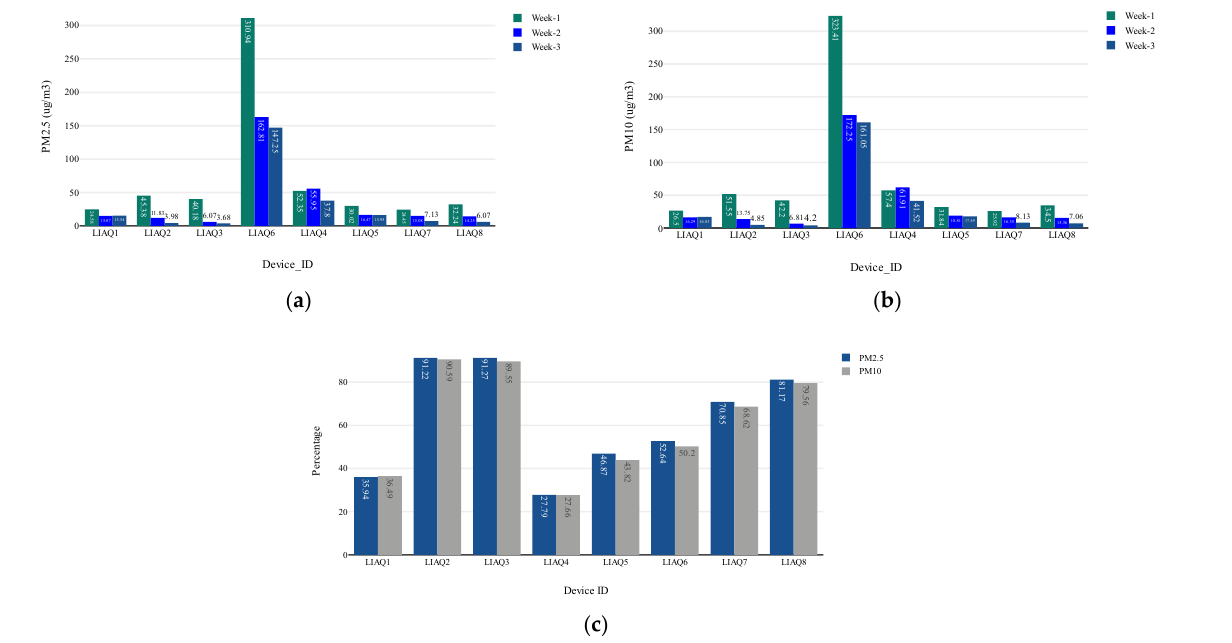
Figure 8. ( a ) Average PM 2.5 data from different households in week 1, week 2, and week 3; ( b ) average PM 10 data from different households in week 1, week 2, and week 3; ( c ) percentage change in the indoor pollution level of PM 2.5 and PM 10. Table 8. The weekly average reading of RH, PM 2.5 , and PM 10 from IAQ